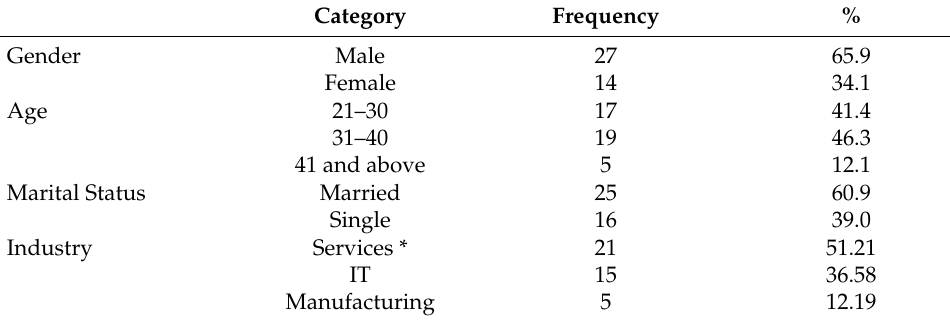
Table 1. Demographic information of participants ( n =